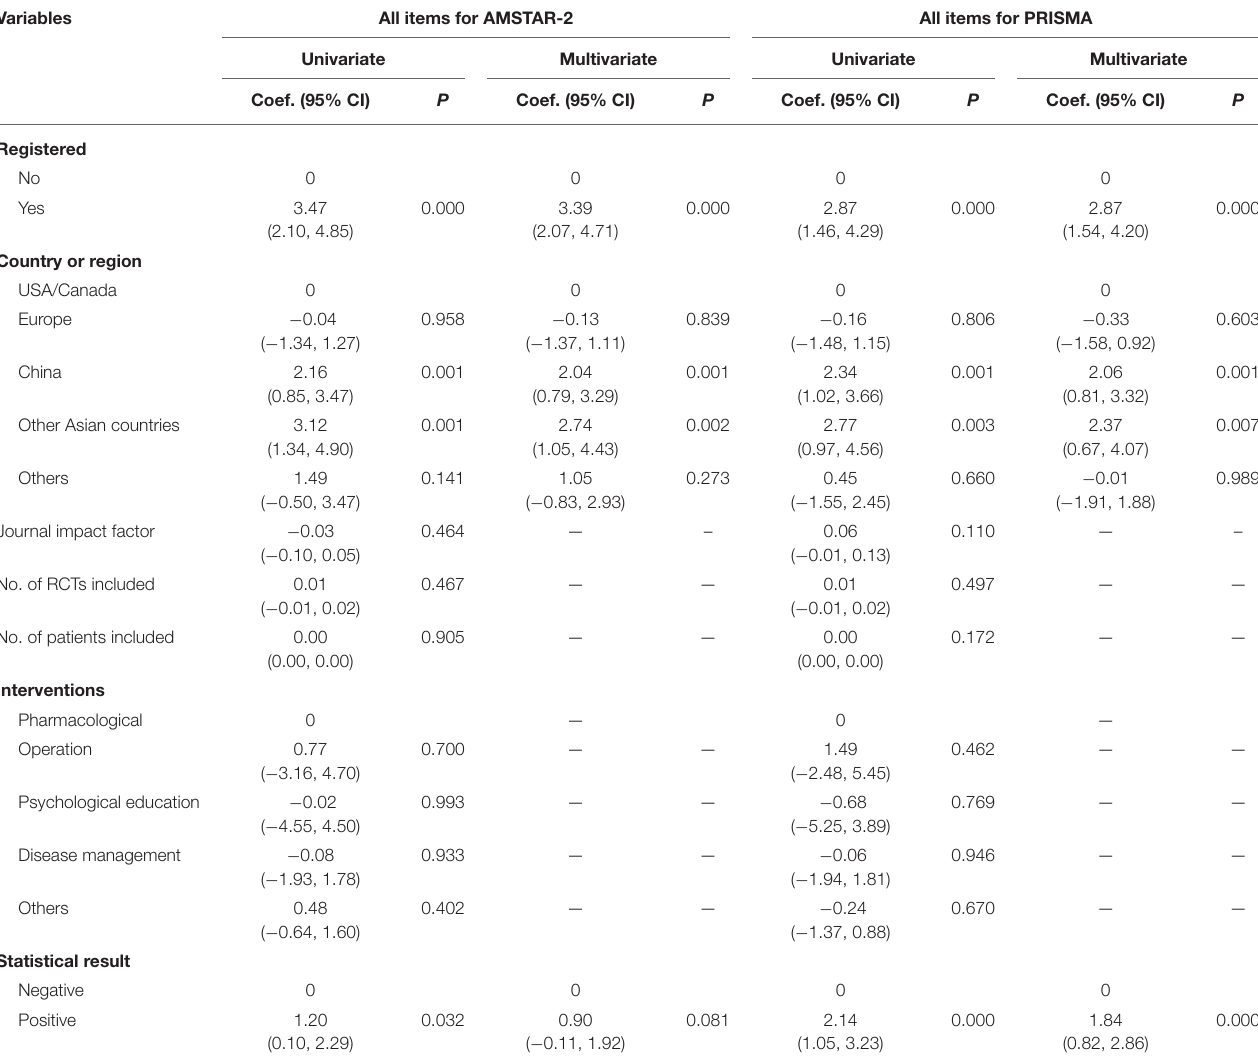
TABLE 2 | Results of linear regression analyses for variables associated with AMSTAR-2 scores and PRISMA scores.